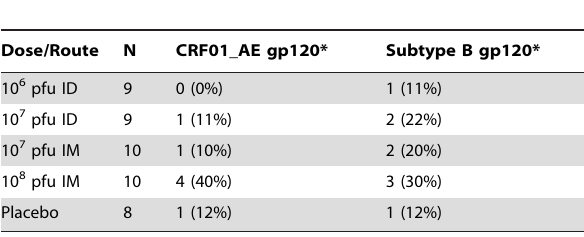
the RV144 trial [5]. Table 7. Cumulative frequency of post-vaccination positive ADCC